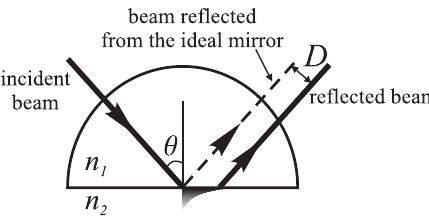
Figure 6. Illustration of the Goos–Hänchen effect. The lateral shift D of the totally reflected beam ( n 1 > n 2 ) is observed. Reprinted from V.V. Moskalenko, I.V. Soboleva, A.A. Fedyanin, JETP Lett.